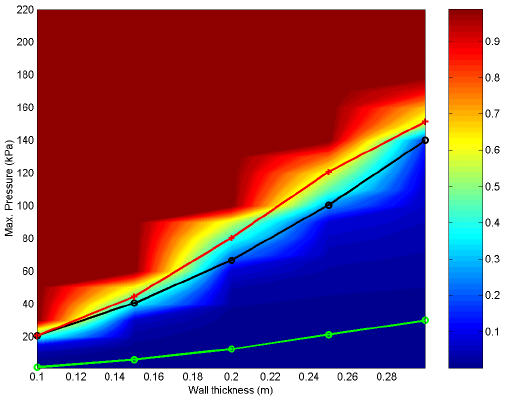
Fig. 19. Vulnerability function ( I D ) obtained for several values of wall thickness ( e